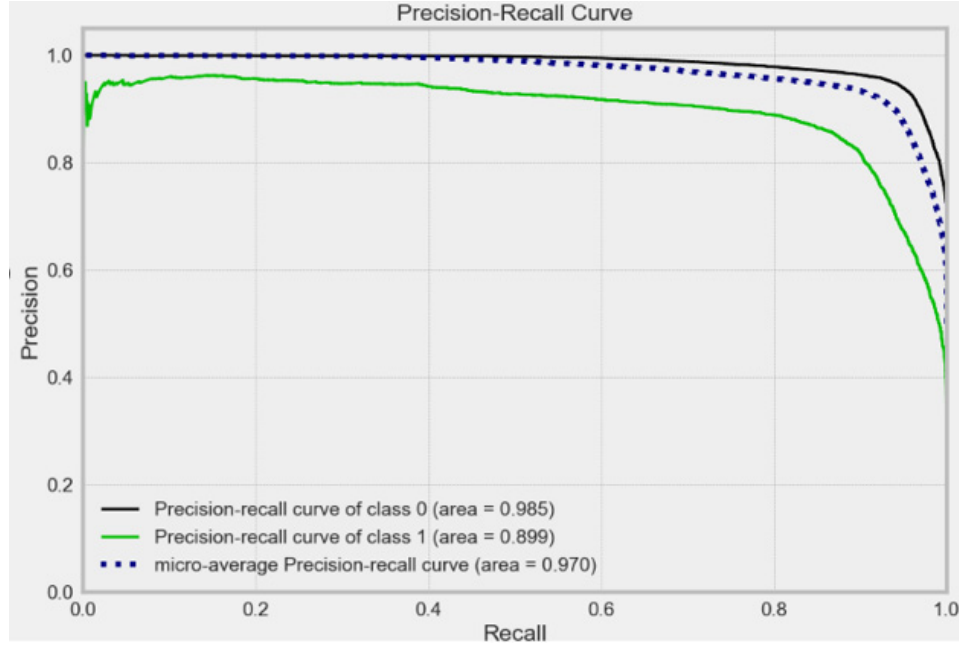
Figure 16. ROC Curves for XGBoost model.